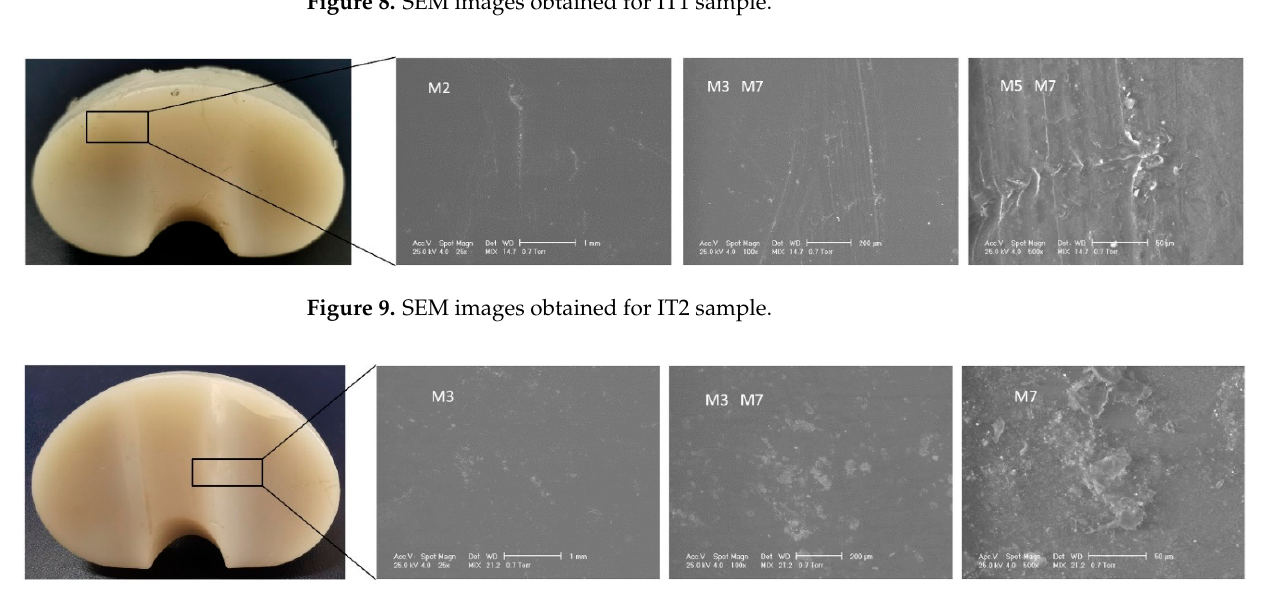
Figure 11. SEM images obtained for IT4 sample. Through SEM microscopy, the retrieved tibial component surface can be investigated at a micrometric level. This type of analysis is very accurate. However, some deformation modes, such as burnishing and surface deformation, cannot be observed. Consequently, this method must always be combined with macrophotography and/or stereomicroscopy to obtain a precise result and an exact computation of the Hood index. From the SEM images, it can be concluded that debris of PMMA cement or bone are absent. This deteri- oration mode can be put in evidence only through scanning electron microscopy because, in the case of the macroscopic observations, it is impossible to be observed. In Table 2 are presented the Hood index values computed based on experimental observations for the four retrieved tibial inserts. Table 2. Surface deterioration modes and Hood index computation for the retrieved UHMWPE tib- ial inserts. Sample ID